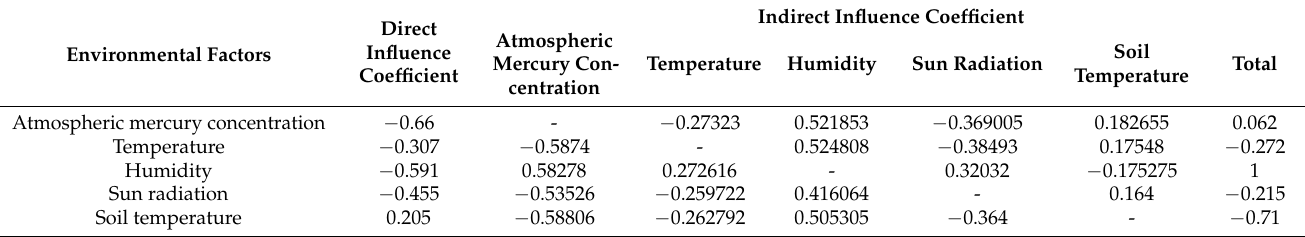
Table 9. Path analysis of the mercury flux and environmental factors during the vegetative reproductive stage of Setaria .